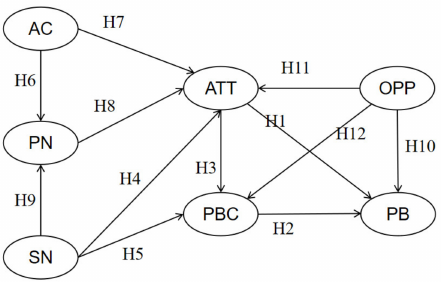
Figure 1. Integrated analytical model. Note: H = hypothesis.